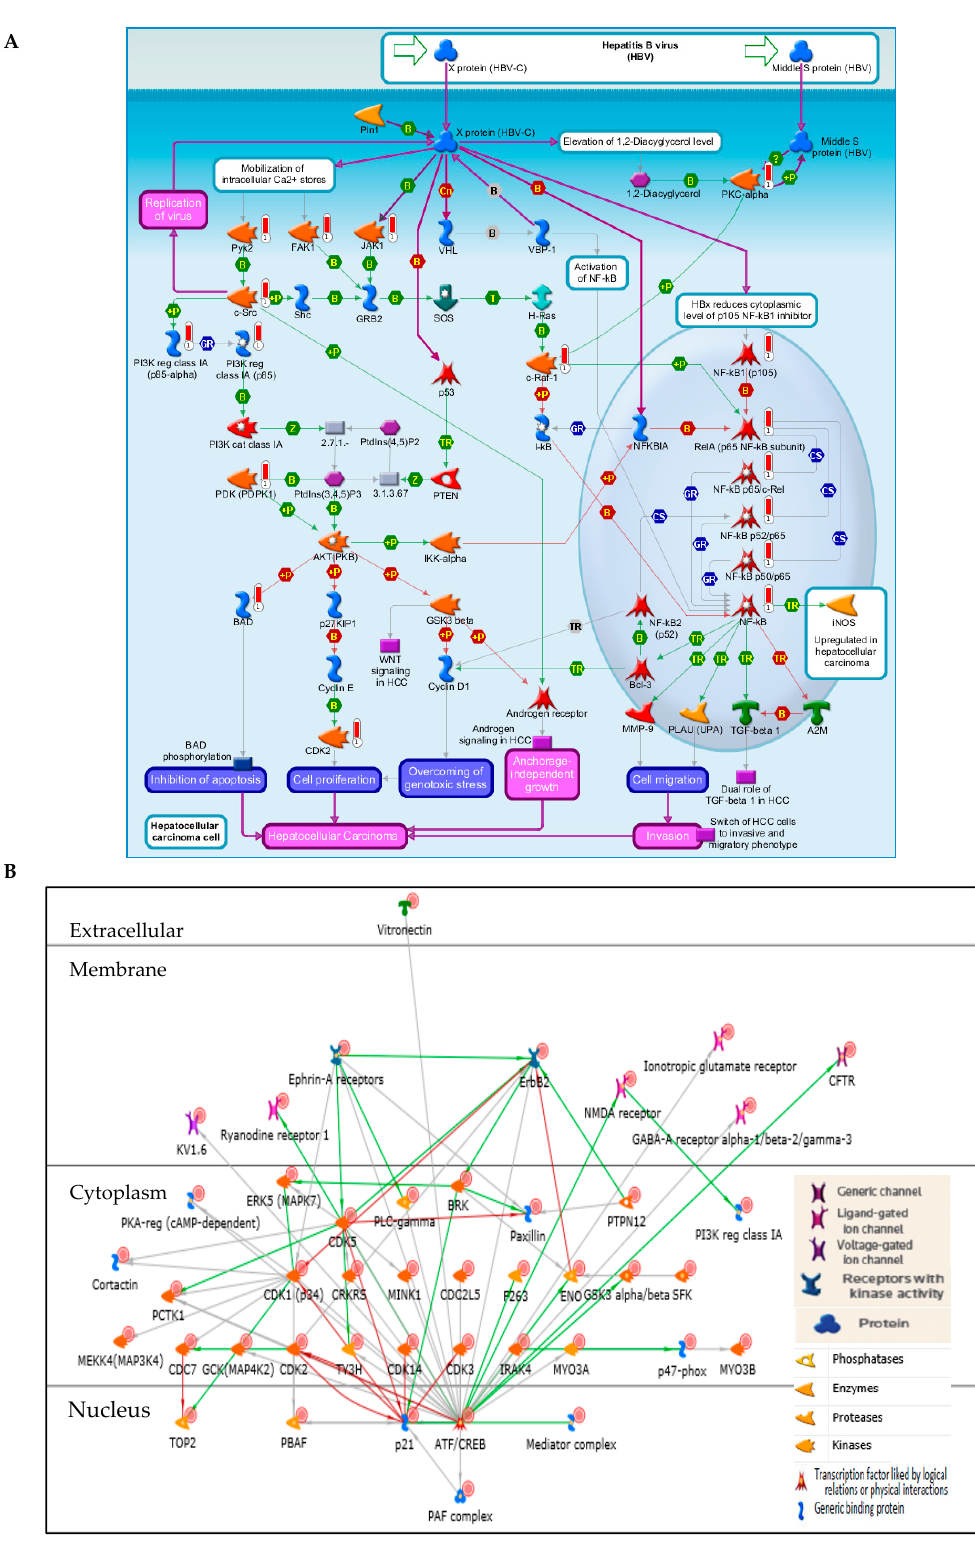
Figure 2. ( A ) Pathway map of PIK3CA/AKT. Symbols looking like a thermometer represent the kinase analysis data. Red color represents protein levels of phosphorylation. ( B ) Peptides with the highest signals in the PI3K/AKT network (PIK3CA